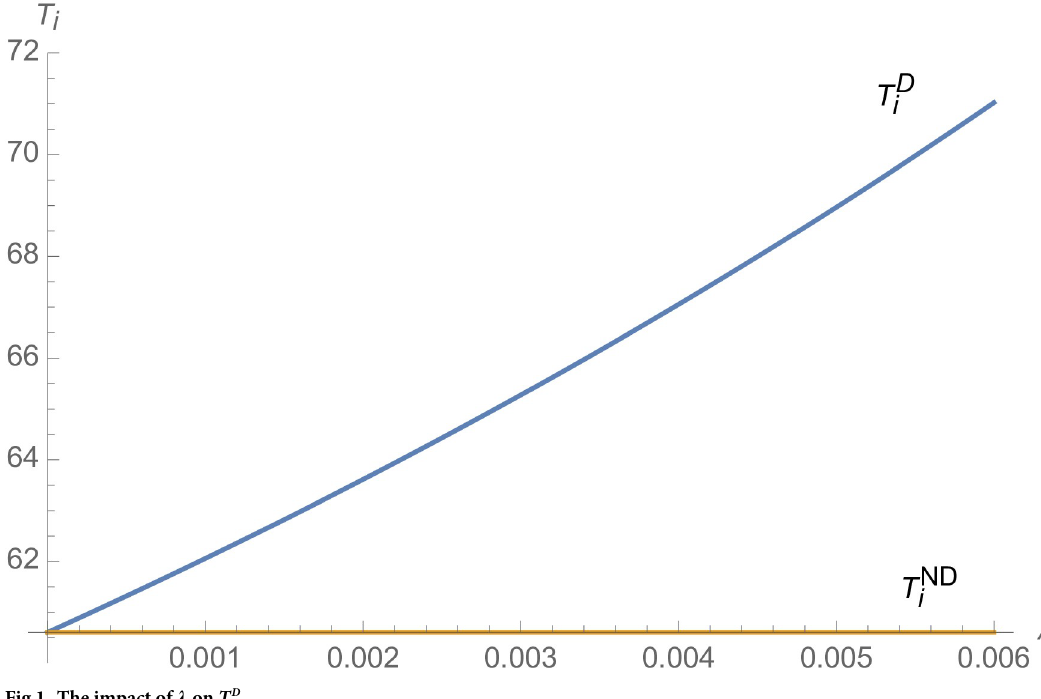
Fig 1. The impact of λ on T D